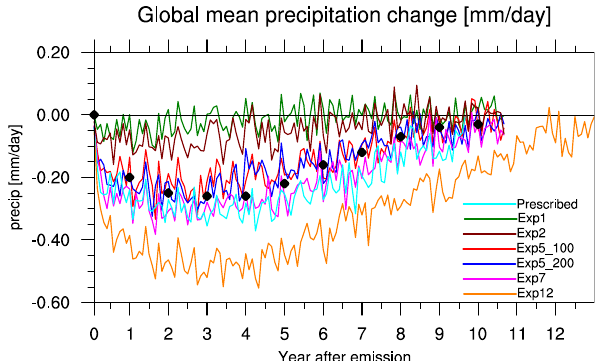
Fig. 9. Global mean precipitation changes [ mmday − 1 ] as function of time. The black diamonds in the upper panel indicate the global mean precipitation changes in May of each year for the 5Tg case by Robock et al. (2007b, their Fig. 3).